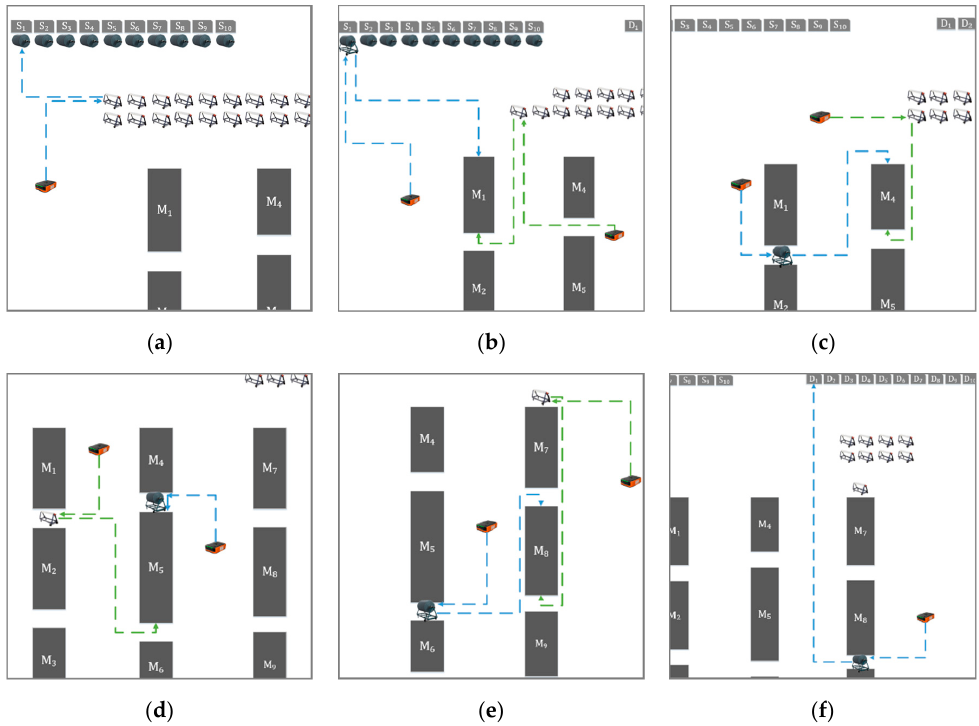
Figure 13. 10 tasks created by the cloud system to transmit the K 1 semi-manufactured fabric to the